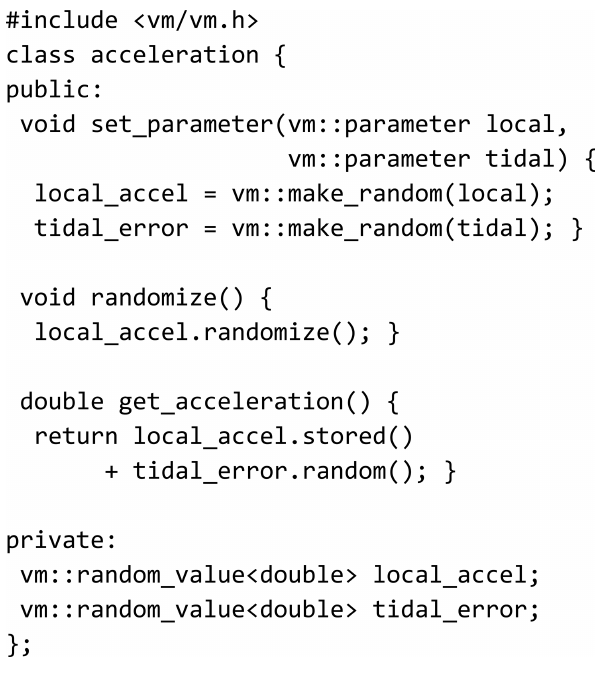
Fig. 2. The module contains two RNGs ( local_accel and tidal_error ) which are stored as private class